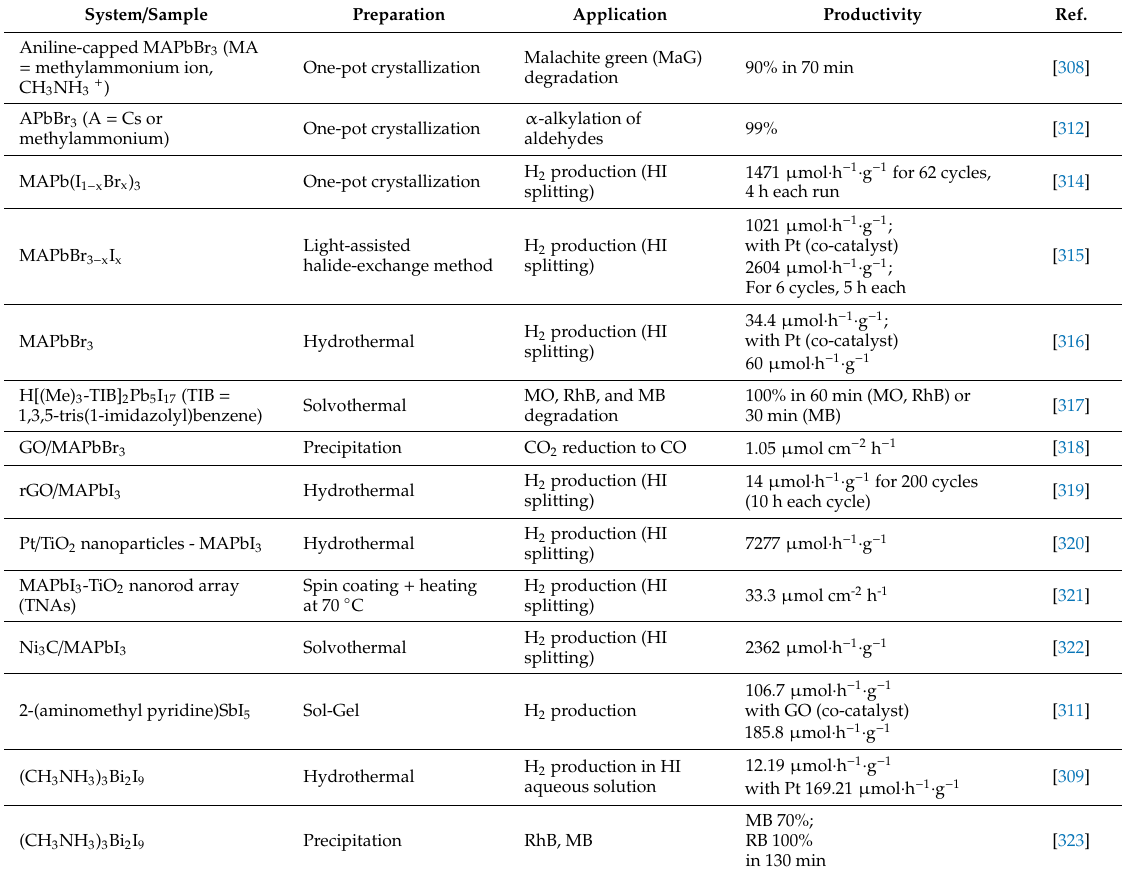
Table 7. Hybrid perovskites and data on their photocatalytic activity under visible irradiation or solar light irradiation. The best results achieved in each work are